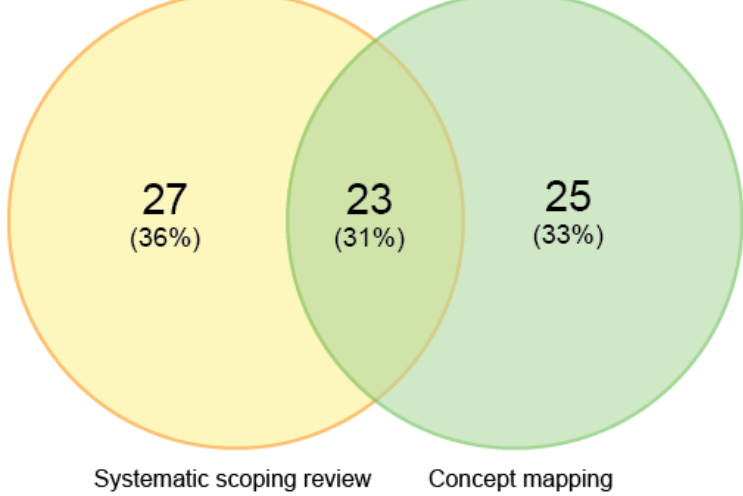
Figure 2. Venn diagram showing the origin of the 75 unique evaluation